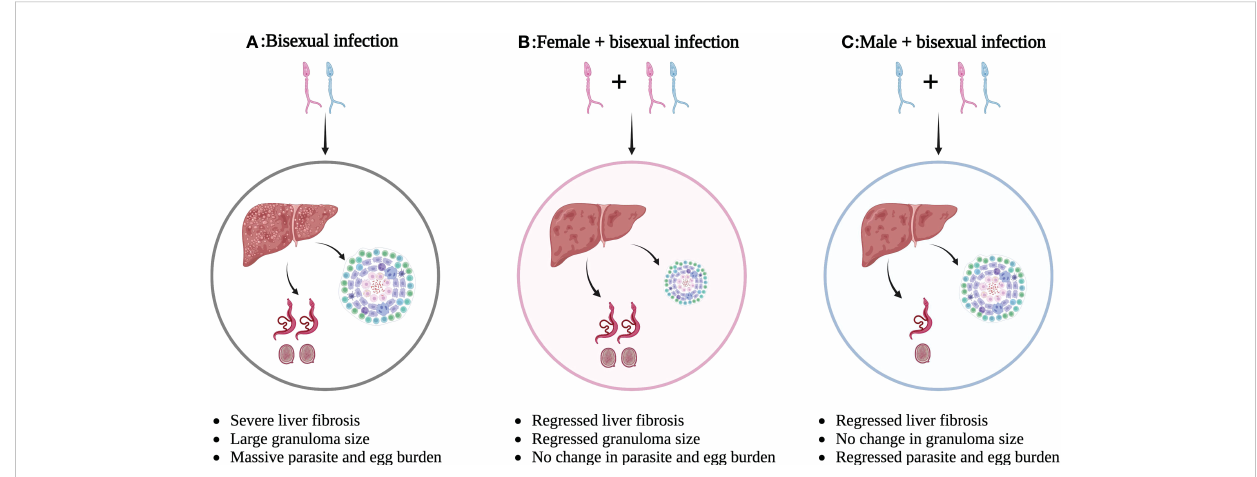
FIGURE 1 Different outcomes of single-sex schistosome-induced hepatic fi brosis. (A) Bisexual schistosome infection leads to severe liver fi brosis with large granuloma size and massive parasite/egg burden; (B) Bisexual schistosome infection after female infection leads to regressed liver fi brosis with smaller granuloma size, but no change in parasite/egg burden; (C) Bisexual schistosome infection after male infection leads to regressed liver fi brosis with regressed parasite/egg burden, but no change in granuloma size. This fi gure was created with Biorender.com. Arrows indicate the result of the next